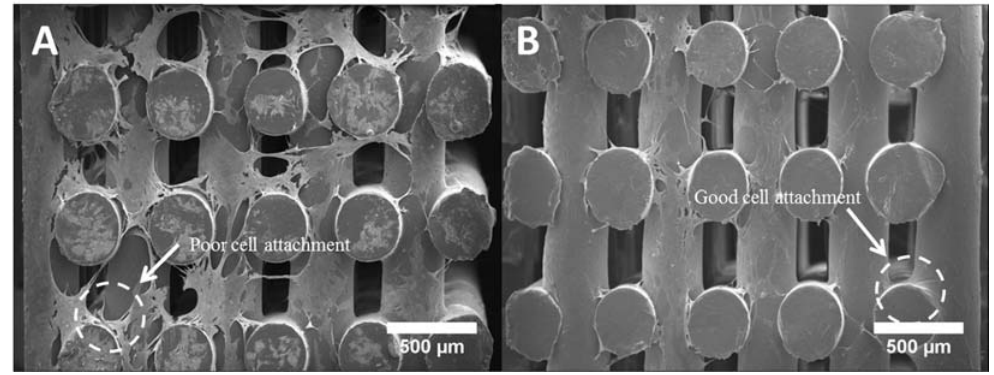
Figure 11. Cross section of ( A ) a PCL scaffold and ( B ) a PCL/HA scaffold after 14 days of cell culture.